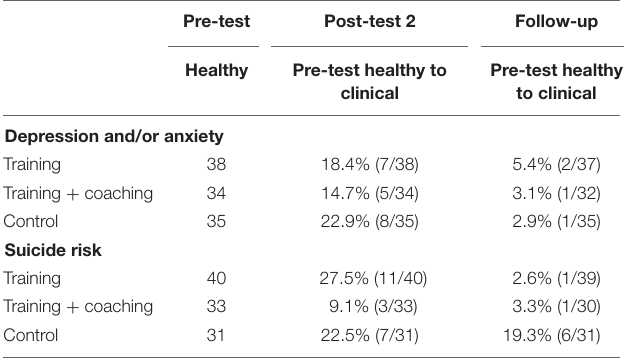
TABLE 4 | Incidence of clinical disorders at post-test 2 and follow-up: proportions of training, training and coaching, and control students who changed their pre-test diagnosis from healthy to clinical.